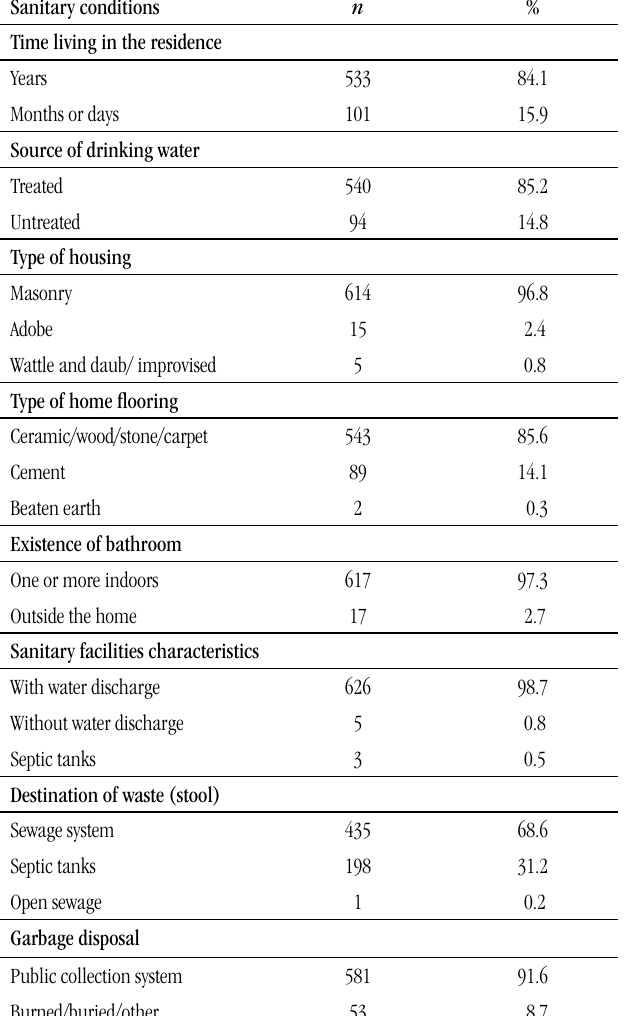
tABLE 1 – Sanitary conditions of the families of the students from public elementary schools in the city of Divinópolis-MG